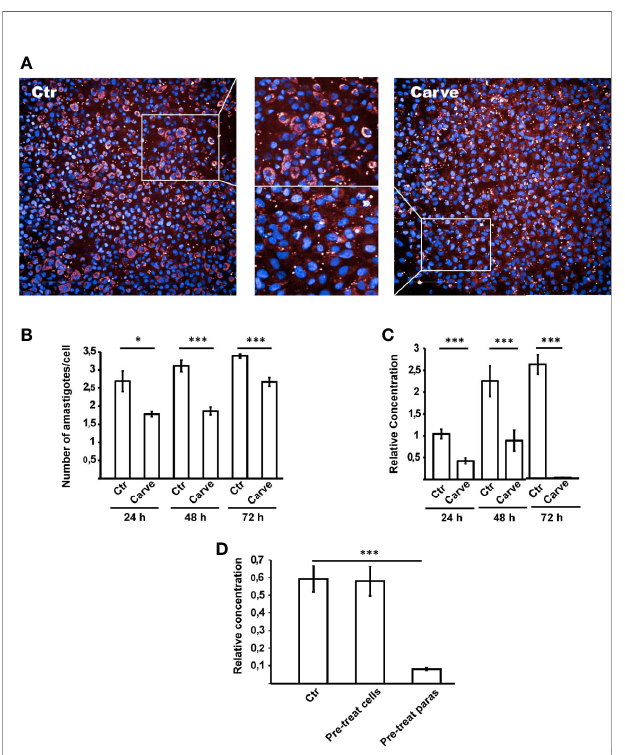
FIGURE 6 | Carvedilol has a trypanocidal effect on T . cruzi trypomastigotes. Trypomastigotes of T. cruzi Tulahuen strain were incubated in the absence (DMSO, Ctr) or the presence of 10 m M carvedilol for 24 h followed by Tunel assay for fl ow cytometry. Other samples of parasites were treated with DNAse or heated to 90°C for 5 minutes and used as negative and positive controls respectively. (A) Graphs depict the 2D plot of each condition. (B) Percentage of apoptosis-like process calculated from the data obtained in (A) Data are shown as mean +/- standard error of 2 independent